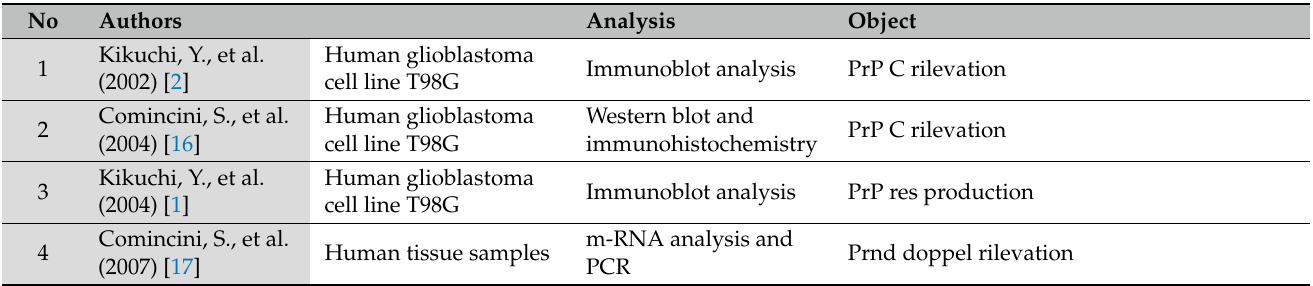
Table 1. Table reports some of the most important research-line on the role of PrPC in glioma